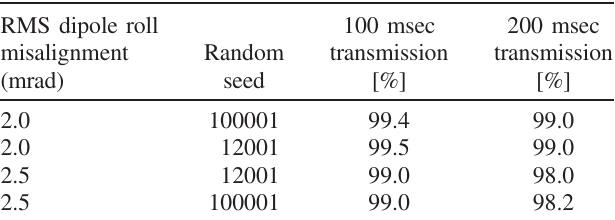
TABLE IV. Polarization transmission to 18 GeV for random gaussian dipole rolls with SVD orbit correction for 4 different random seeds (calculated using spin tracking in Z GOUBI